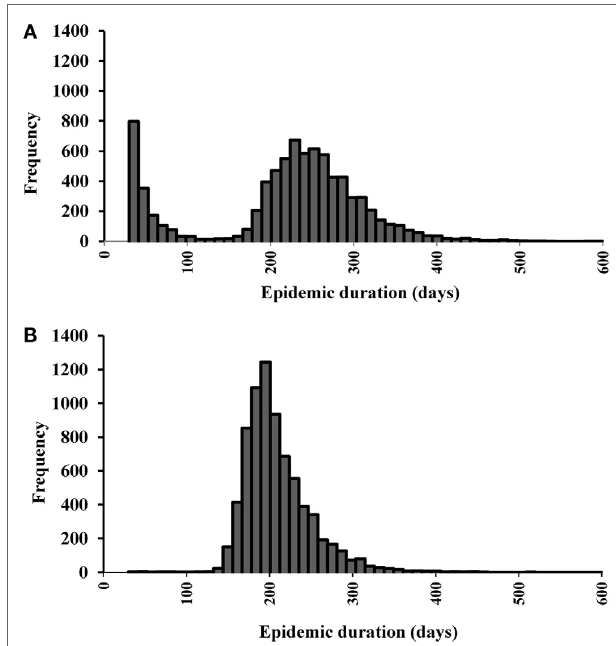
FigUre 2 | histograms of the epidemic duration estimates for (a) 19 most likely single-site classical swine fever outbreak scenarios ( N = 9,500 iterations). (B) 15 most likely multiple-site outbreak scenarios ( N = 7,500